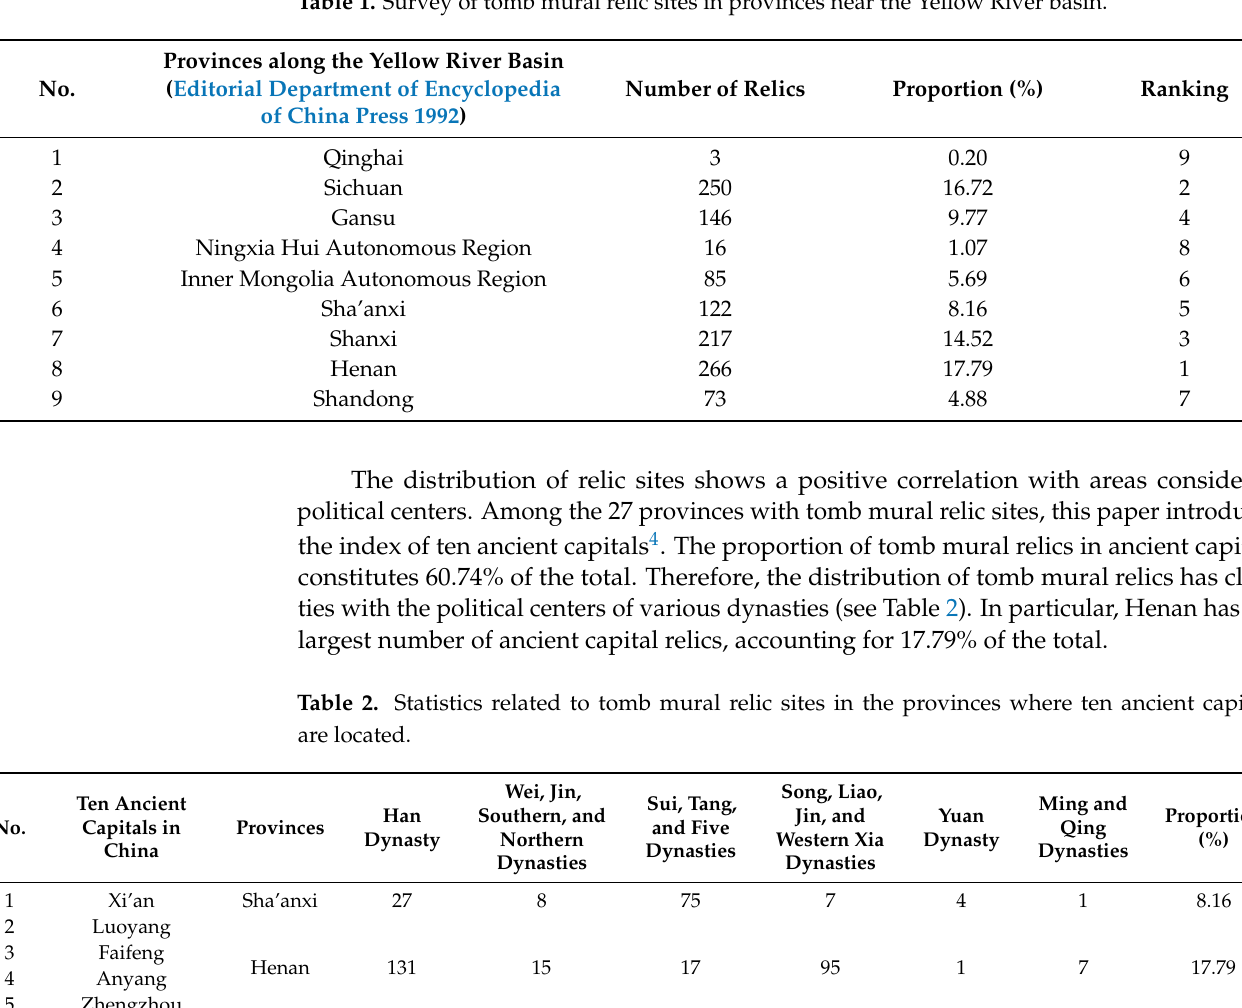
Table 1. Survey of tomb mural relic sites in provinces near the Yellow River basin.